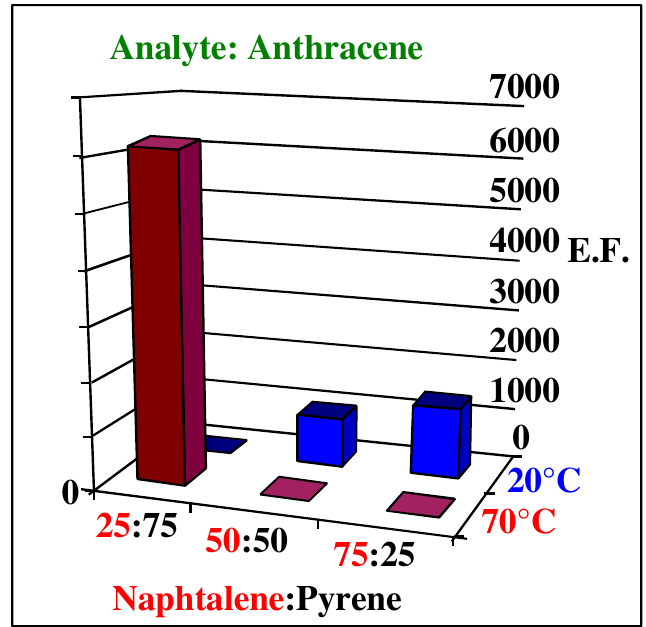
Figure 6: Enrichment factors of polyurethane layers imprinted with different template mixtures at 20°C and